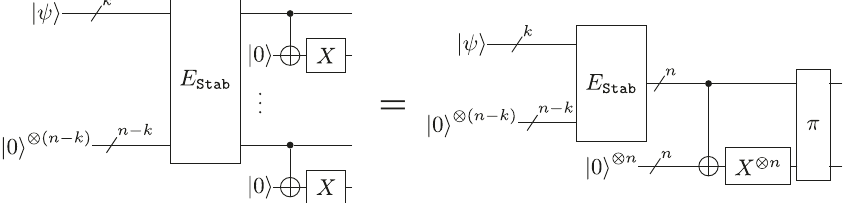
Fig. 1 Encodings of C Stab ; KLM from the encoding E Stab of C Stab . On the right side, CNOTs apply transversally to each pair of control and target qubits in the code blocks. The permutation π maps the j th qubit in the fi rst block of n qubits to the (2 j − 1)th qubit and the j th qubit in the second block of n qubits to the (2 j )th qubit.